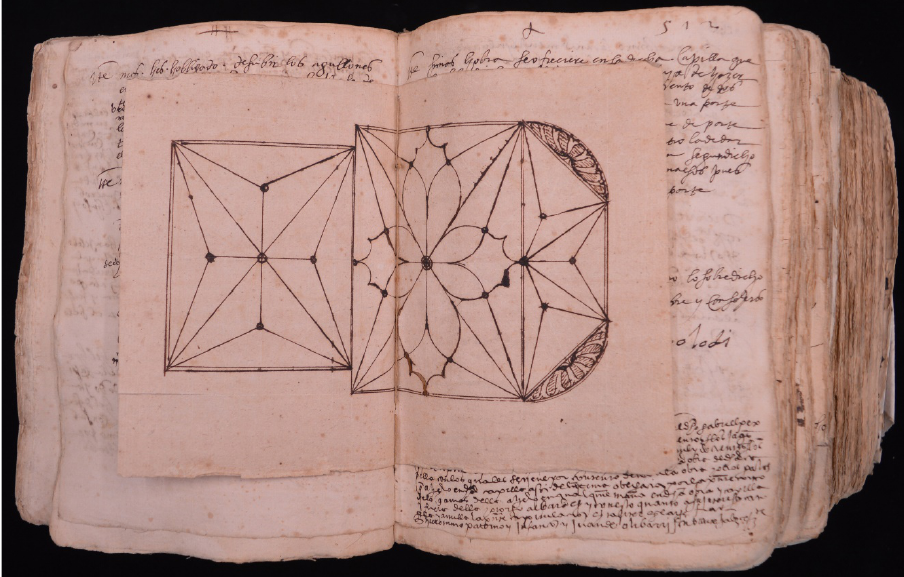
Figure 16. Project for the vaulting of the chapel of Nuestra Señora del Remedio at the monastery of San Lamberto in Zaragoza [A.H.P.N.Z., Lorenzo Villanueva, 1556, ff. 510 v-513 r]. © Archivo Hist ó rico de Protocolos Notariales de Zaragoza. Arts 2023 , 12 , x FOR PEER REVIEW